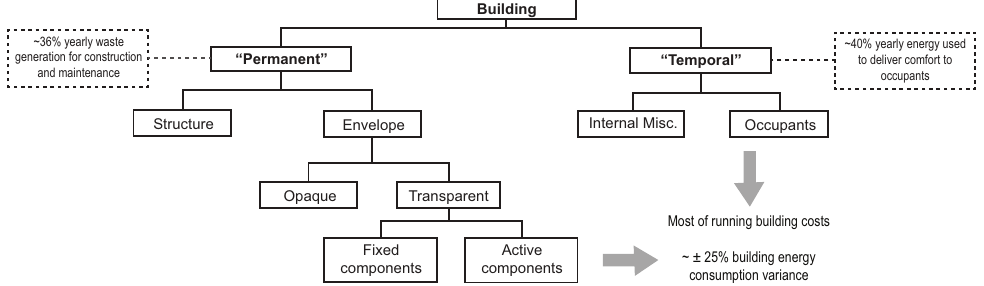
Figure 1. Building components deconstruction outline, and building-occupants interaction potential outcome on climate burden. Based on data collected for the European